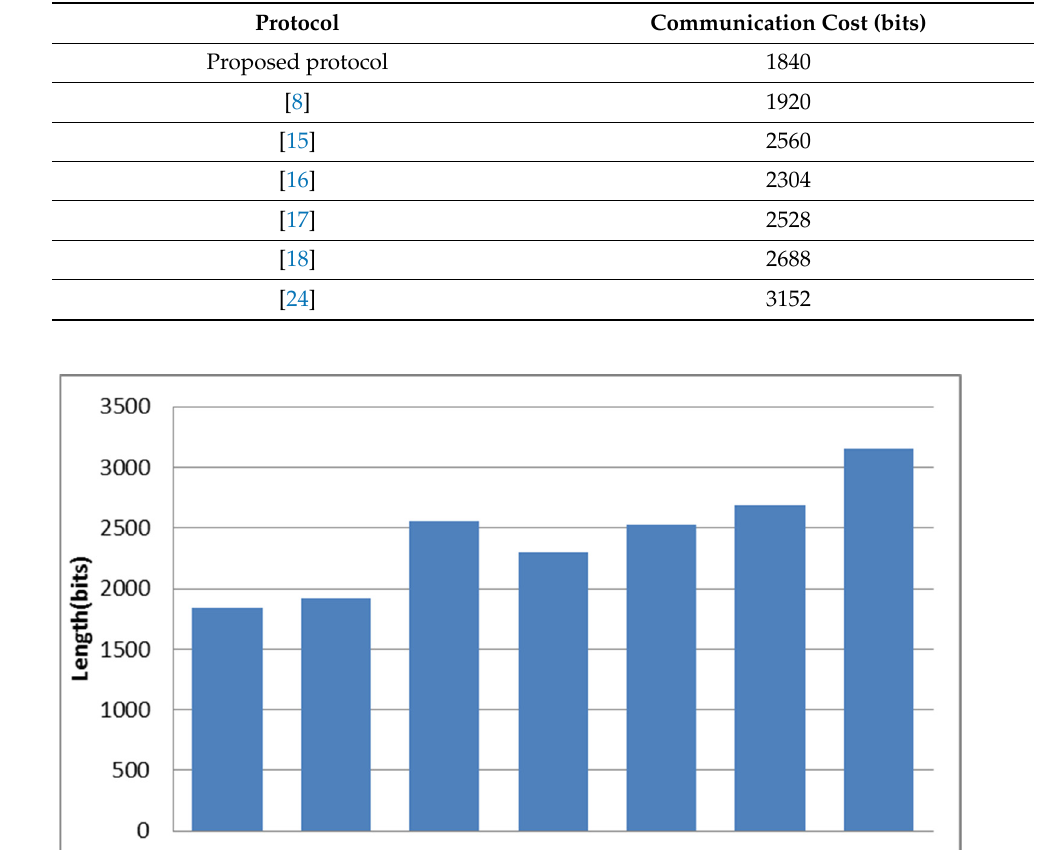
Table 3. Approximate time taken by each cryptographic operation [17].